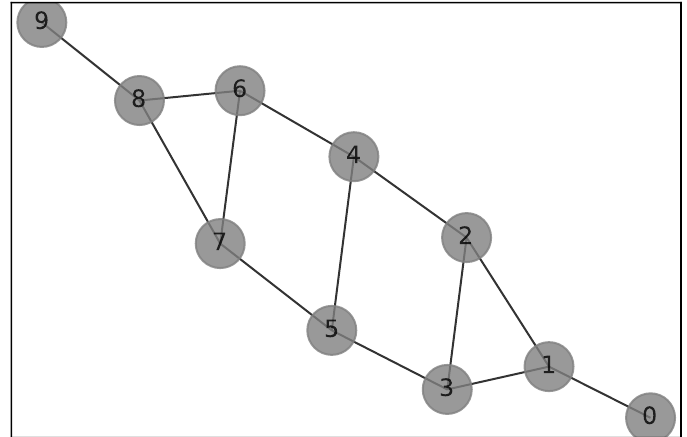
Figure 2. Value stream network with n = 10